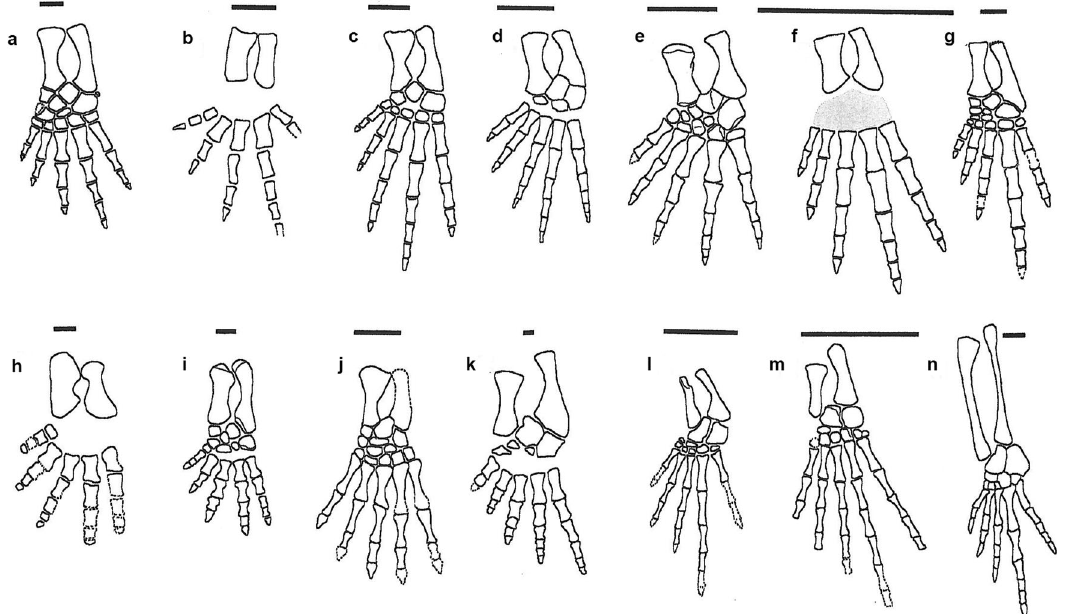
Fig. 4 Comparison of the left tibia, fi bula, tarsus, and digits of early tetrapods. a Balanerpeton after 2, b Eucritta after 12, c Eldeceeon after 6, d Silvanerpeton after 4, e Westlothiana after 7, f Kirktonecta original, see 15 (the grey area marks the estimated position and extent of the tarsus), g Termonerpeton , h Pederpes after 24, i , Greererpeton after 27, j Caerorhachis after 31, k Archeria after 30, l Hylonomus after 28, m Tuditanus after 22, n Petrolacosaurus after 29. Drawn to the same tibial length apart from n . Scale bars 10